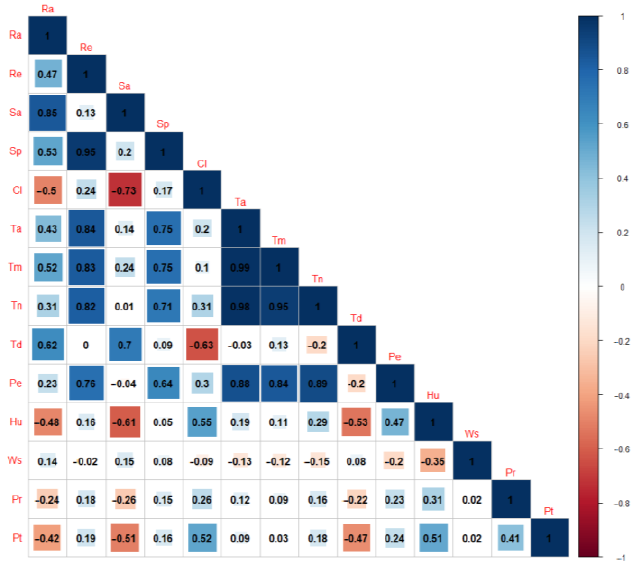
Figure 2. Correlations among different meteorological items.